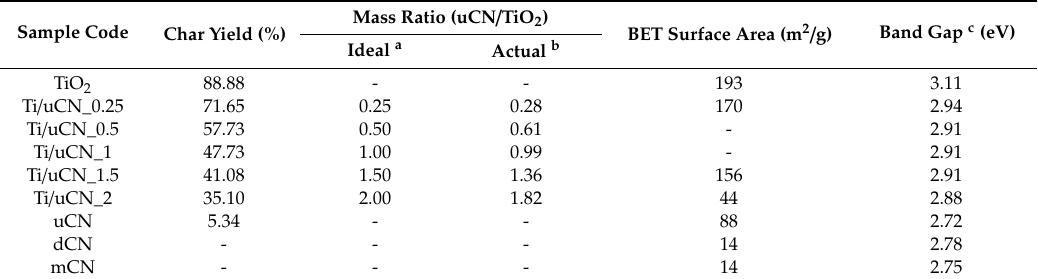
Figure 2. SEM and TEM images of: ( a , a ′ ) uCN; ( b , b ′ ) mCN; and ( c , c ′ ) dCN. Table 1. Characteristics of Ti/uCN_x, TiO 2 and uCN samples.